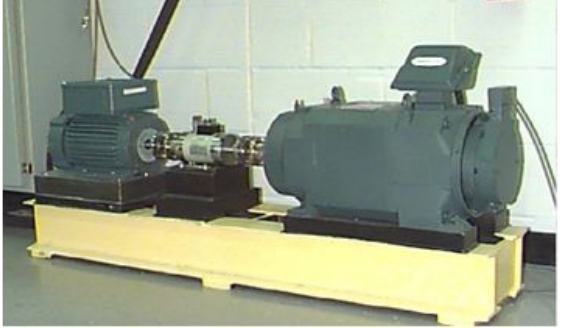
Figure 6. The CWRU bearing testing rig: the motor (left), the torque sensor/encoder (middle) and the dynamometer (right).